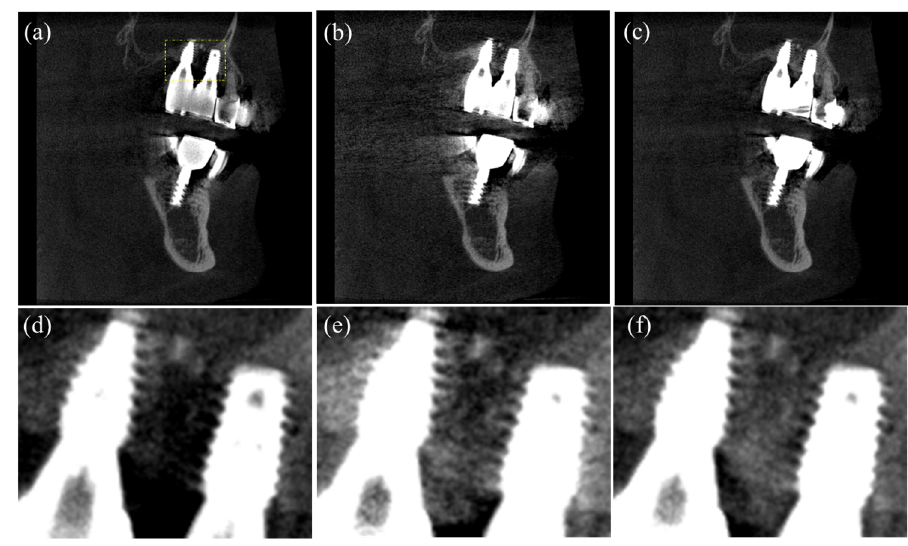
Figure 13. Sagittal-view images of the patient shown in Figure 10. ( a ) The uncorrected image. ( b ) The image corrected by the DSC method. ( c ) The image corrected by the proposed method. ( d – f ) The corresponding zoomed image at the ROI shown in Figure 13a. (Contrast window is [ − 625~5083] in Hounsfield